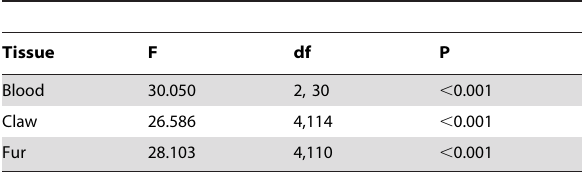
Table 2. Multivariate general linear models for differences in carbon and nitrogen stable isotope composition between the three